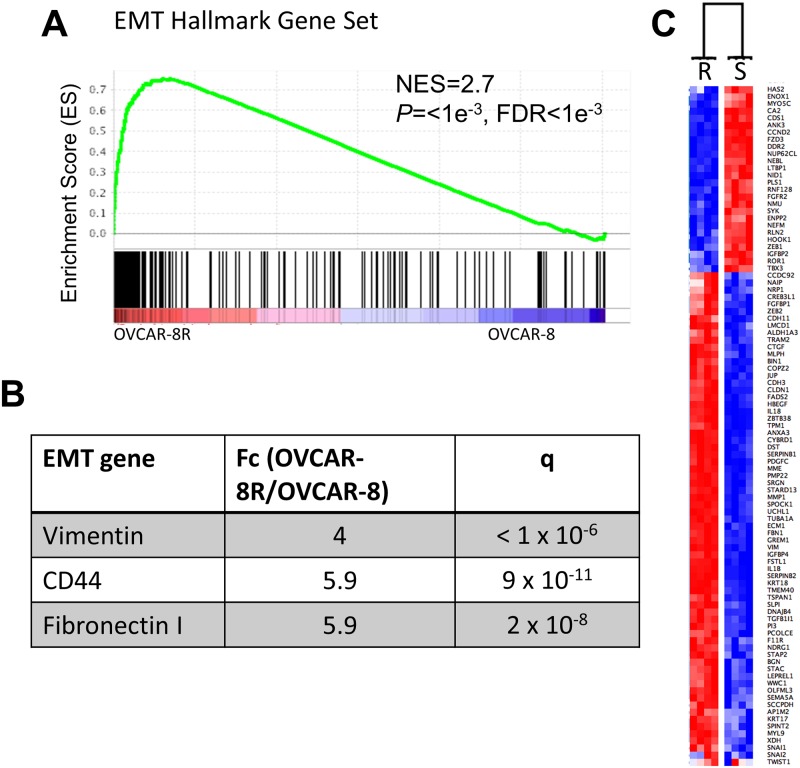
Cisplatin resistance genes significantly overlap with genes associated with the mesenchymal state.(A) GSEA enrichment shows that the EMT hallmark gene set is significantly biased towards OVCAR-8R spheroids compared to OVCAR-8. (B) Key mesenchymal markers are significantly up-regulated in OVCAR-8R compared to OVCAR-8 spheroids. (C) The Taube EMT signature separates the OVCAR-8R and OVCAR-8 spheroids by hierarchical clustering using Gene-E with Pearson correlation calculated distances. Each row represents a gene. R is the OVCAR-8R and S is the parental OVCAR-8 spheroids. Red indicates higher risk, blue indicates lower risk.